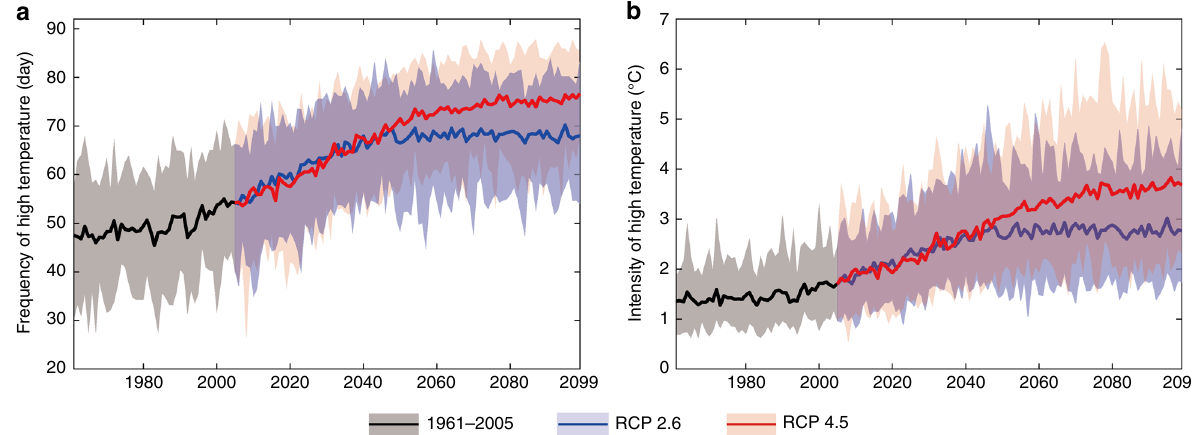
Fig. 1 Frequency and intensity of high temperature in China metropolises for 1961 – 2099. Curves and shadows denote ensemble mean and range of 31 GCMs, respectively. Frequency ( a ) and intensity ( b ) of high temperature in China metropolises for the reference period 1961 – 2005 (gray) and for the future period 2005 – 2099 with RCP 2.6 (blue) and RCP 4.5 (red). Curves and shadows denote the ensemble mean and range of 31 GCMs,